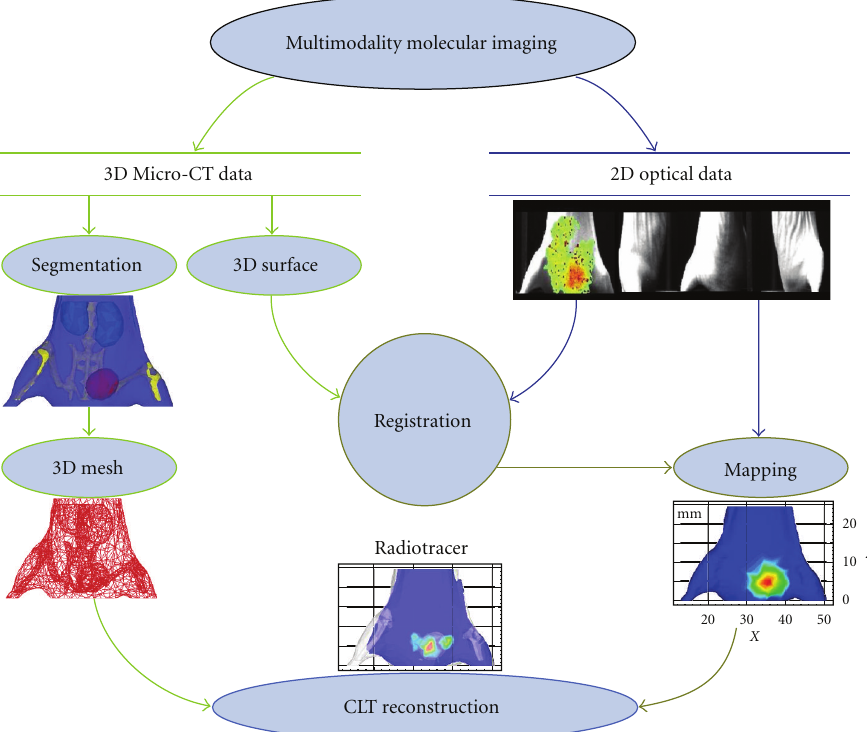
Figure 4: Schematic of radioactive source distribution reconstruction with optical property heterogeneity. The mouse was scanned by our multimodal molecular imaging system. 3D MicroCT data and planar optical images were collected by the same system. The interval degree was 90 for multiangle imaging. 2D optical intensity distribution is mapped on the 3D surface in accordance with the registering relationship. CLT is the output of the information fusion and optical tomography reconstruction.